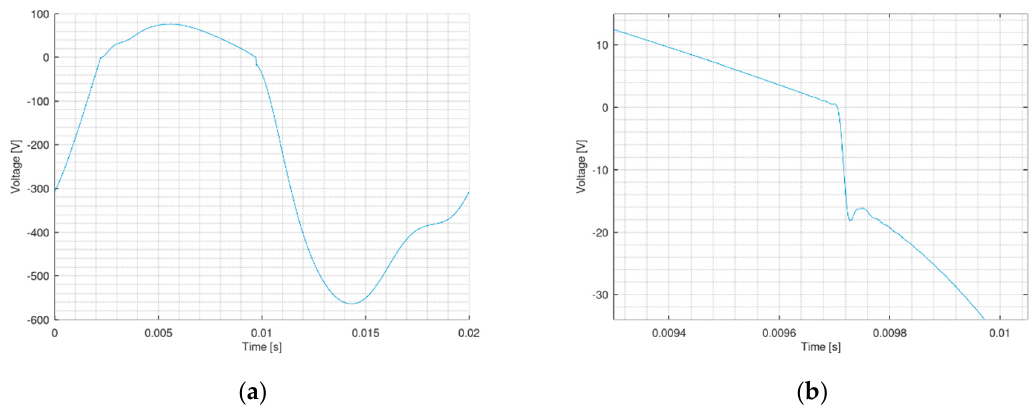
Figure 7. Voltage across the nonlinear element in the time domain: ( a ) for one entire time period; ( b ) detailed view of the Gibbs effect.